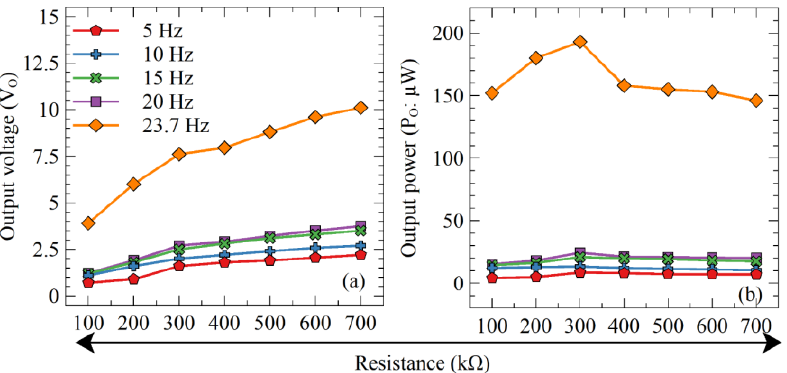
Figure 12. Outcomes of Test 1 through the FBRJT circuit. ( a ) Output voltage, ( b ) output power.